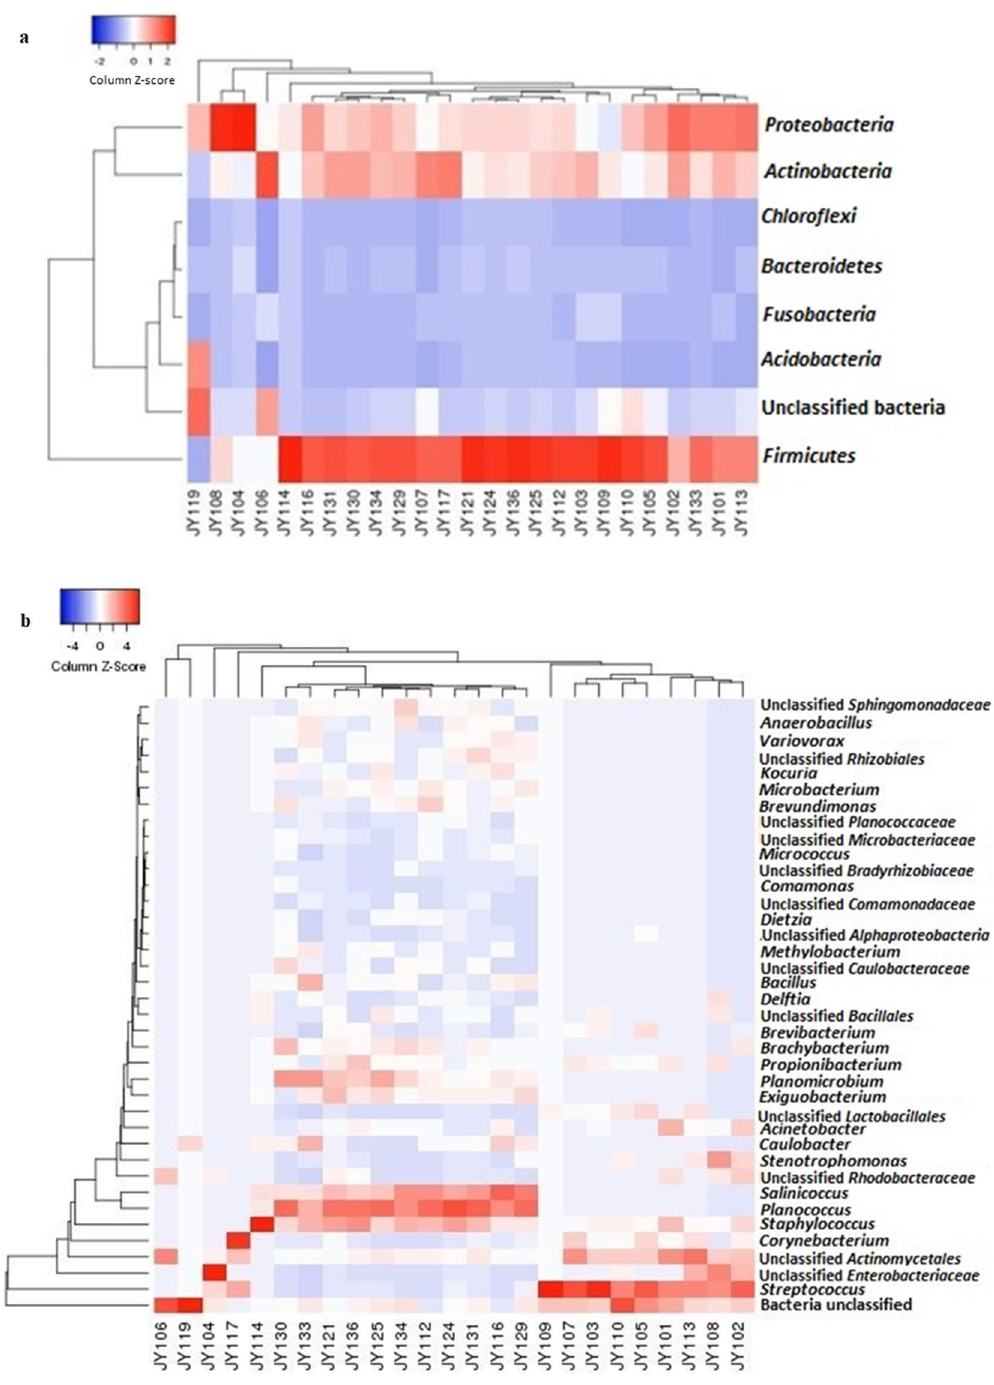
Figure 2. Heatmaps on bacterial abundance in twenty-five yeast strains at; ( a ), phylum level; ( b ), genus level. Other details as in Fig. 1. OTU data was first filtered and normalised using total sum-scaling in MicrobiomeAnalyst web-based tool 27 . The heatmaps were then constructed using Heatmapper web-based tool 29 . Clustering was applied to both column and row data with average linkage method and distances were measured as Euclidean distances. Red colour indicates high abundance and blue colour indicates low abundance as given in the colour scale on the top of the